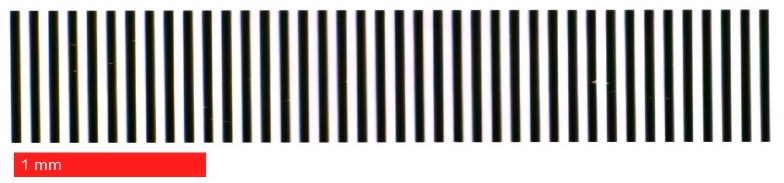
Figure 4. Microscope view of the patterned target.